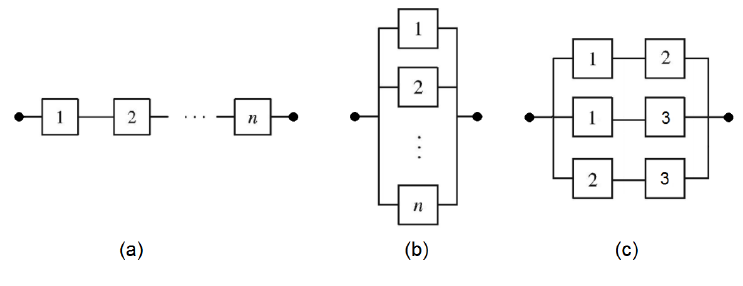
Figure 3. Reliability block diagrams examples (RBD): ( a ) series; ( b ) parallel; and ( c )